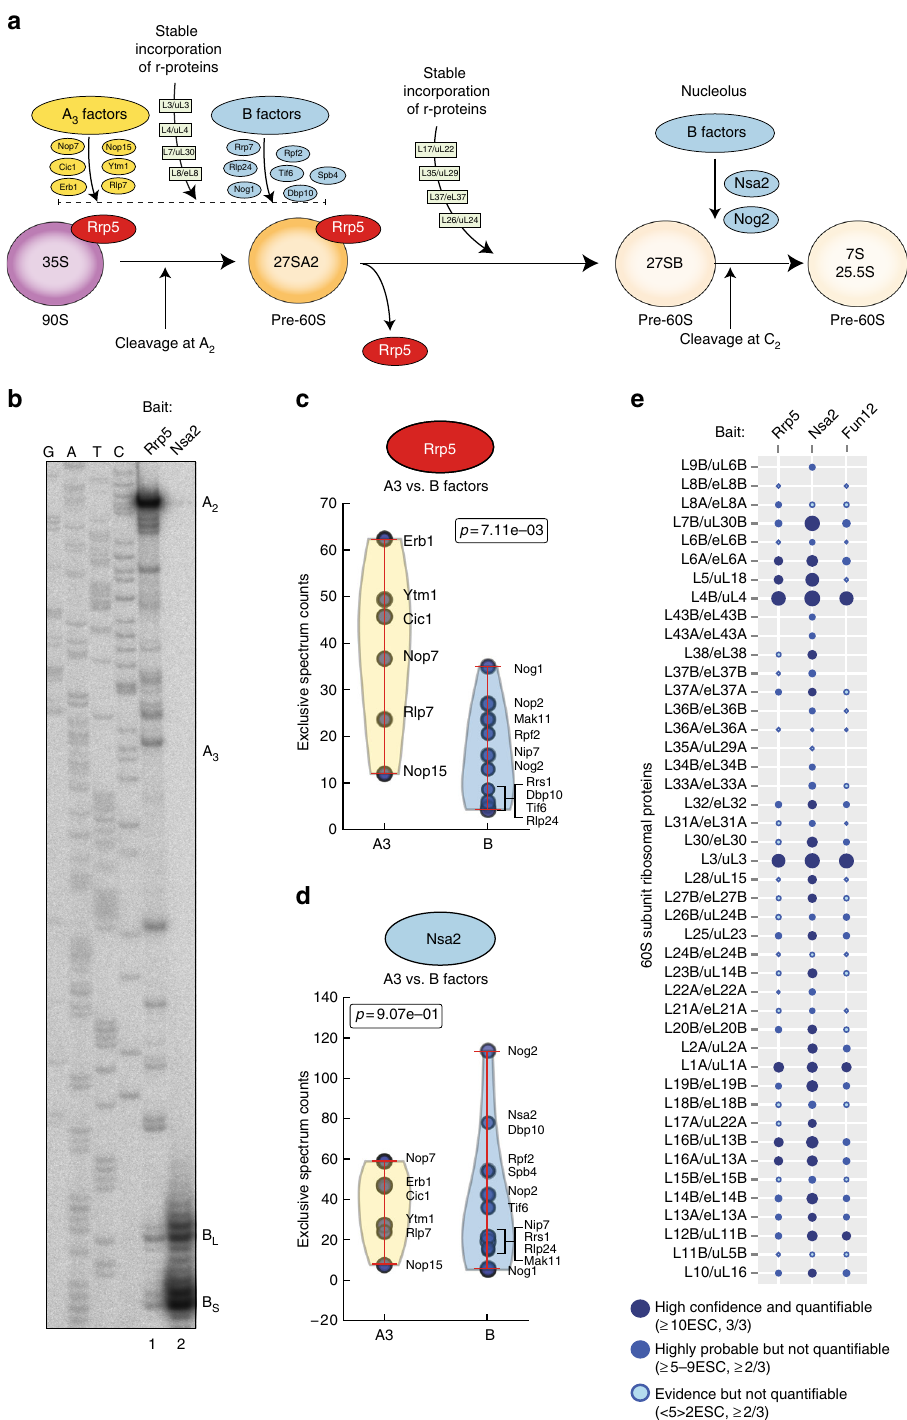
Fig. 1 Af fi nity puri fi cation of 27SA 2 and 27SB pre-rRNA. a Schematic representation of the assembly steps of the nucleolar pre-60S particles. The 35S pre-rRNA is processed to 27SB pre-rRNA in various stages, which involves binding of assembly factors required for 27SA 3 processing (A 3 factors), assembly factors required for cleavage in ITS2 (B factors) and r-proteins. b Primer extension analysis of 27S pre-rRNAs isolated from the Rrp5-TAP and Nsa2-TAP pre-60S particles. The cleavage sites are indicated on the right side of the gel image. Lanes labeled with G, A, T and C represent dideoxy sequencing ladders. c , d Violin plots showing the mass spectrometry results for ribosome assembly factors. The plot shows the distribution of A 3 and B factors based on the ESCs from the Rrp5 ( c ) or Nsa2 ( d ) pre-60S complexes. The p -value was calculated using a t -test. e Ball plots showing the mass spectrometry results (ESC) for the r-protein composition of the complexes puri fi ed by Rrp5-TAP and Nsa2-TAP. The results were compared to the r- protein composition of the Fun12-TAP puri fi ed 80S particles. The larger the ball, the more enriched the protein was in the puri fi cation